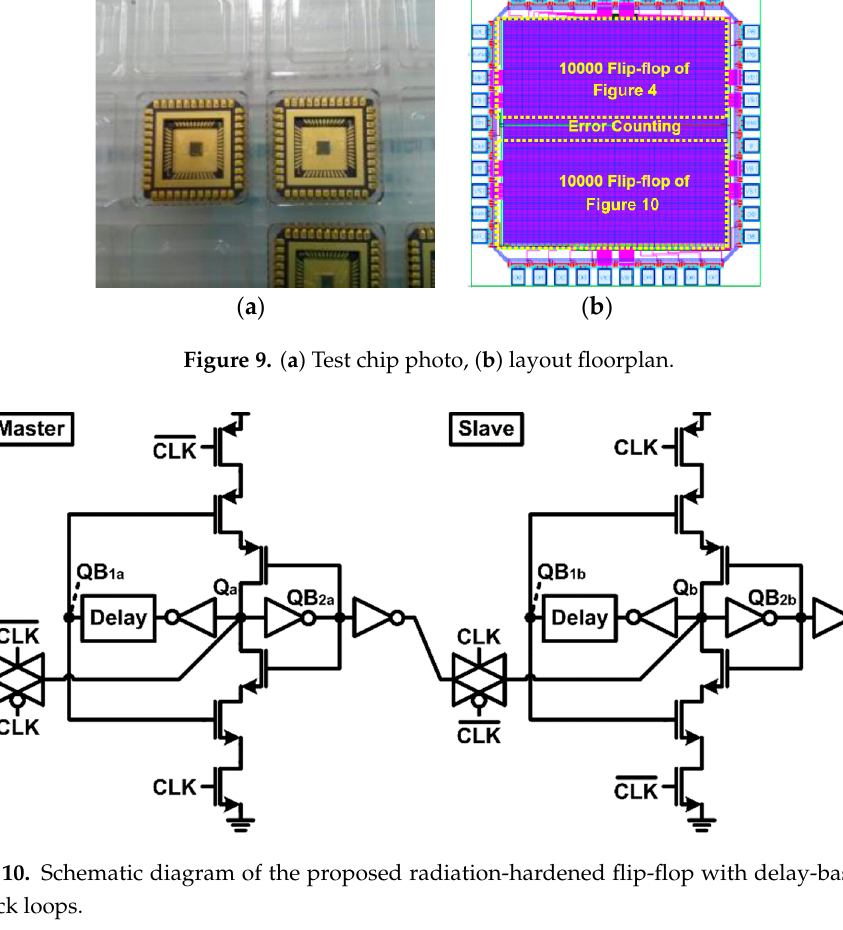
Figure 10. Schematic diagram of the proposed radiation-hardened flip-flop with delay-based dual feedback loops.